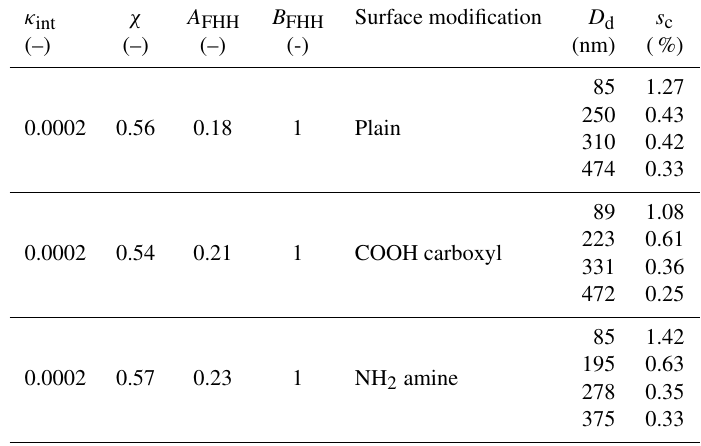
Table 1. Important aerosol physical properties and parameters used to derive droplet